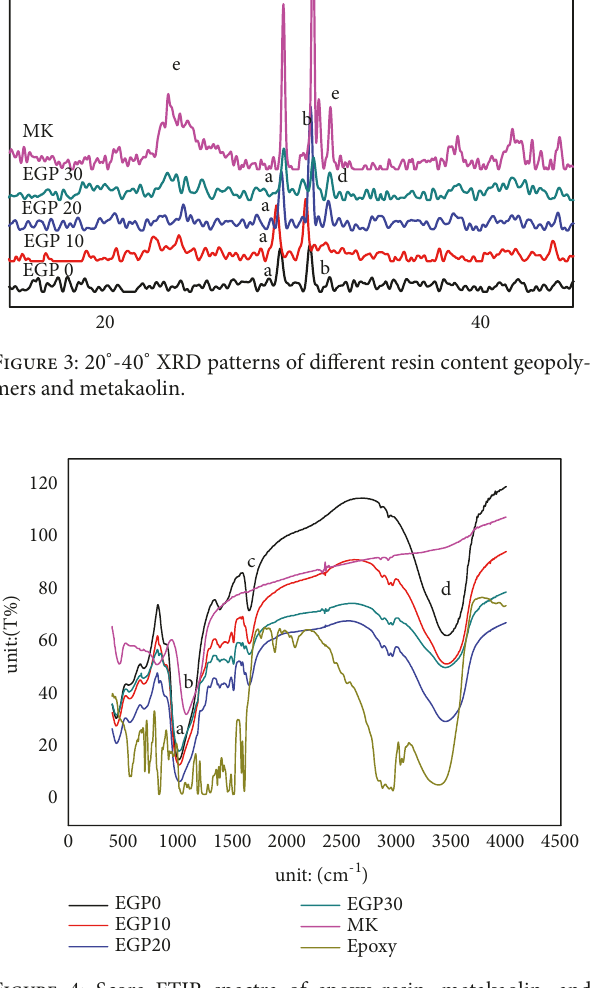
Figure 4: Score FTIR spectra of epoxy resin, metakaolin, and geopolymer with different epoxy resin concentrations.